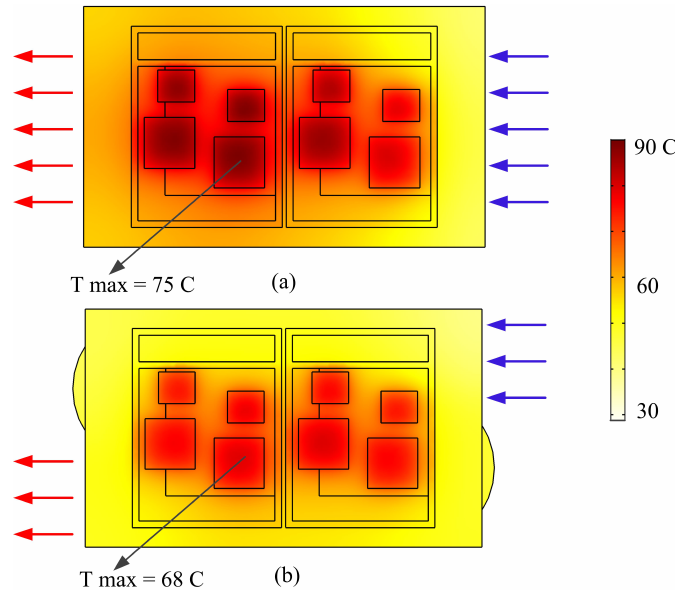
Figure 8. Temperature distribution from chips point of view at volumetric flow rate of 18 cm 3 s − 1 in ( a ) Offset strip fin design, ( b ) New offset